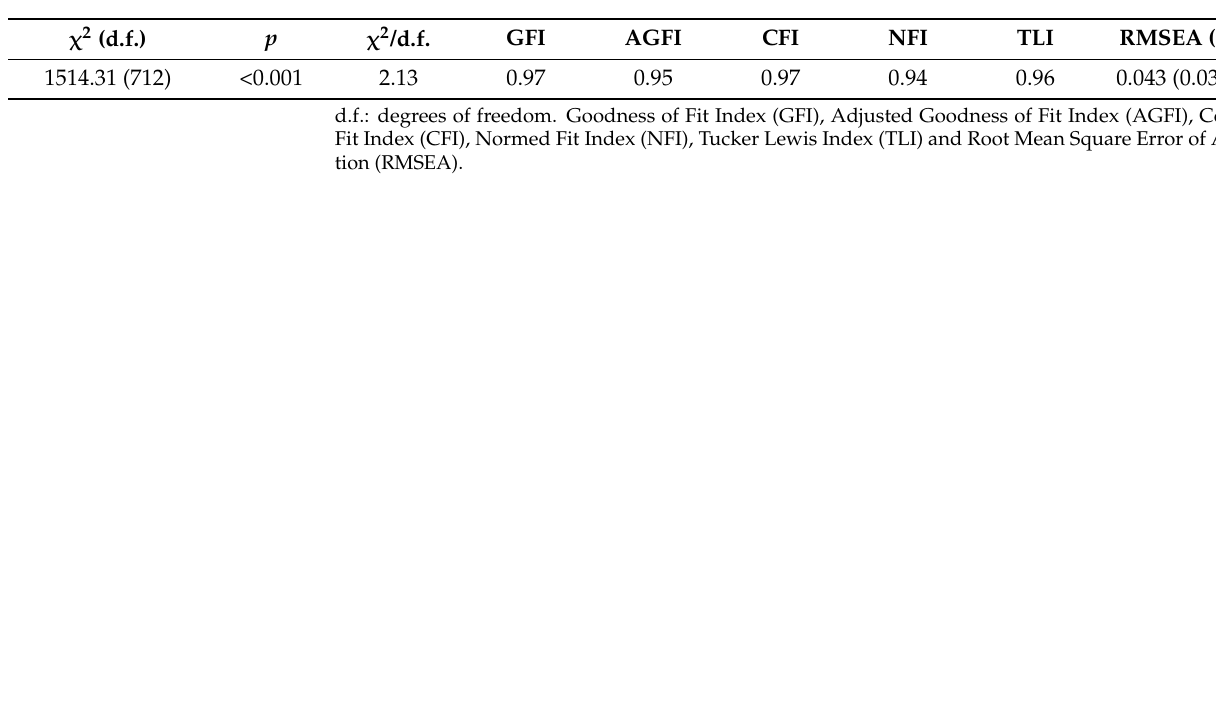
Table 4. AFC goodness-of-fit